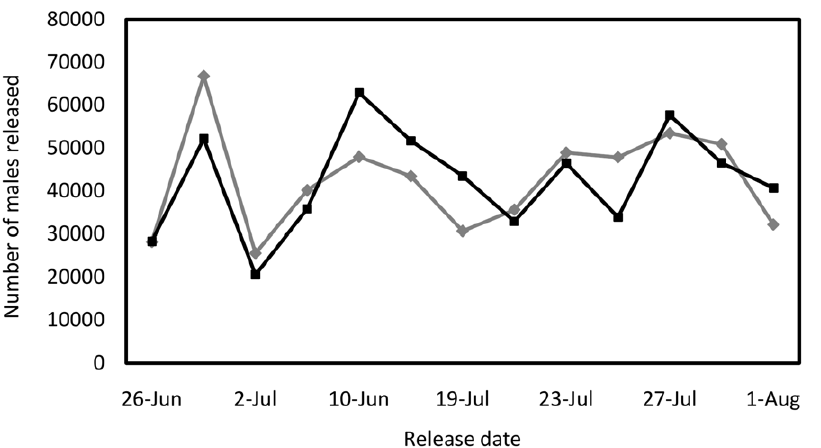
Figure 3. Number of OX1138B and APHIS male moths released over all fields during the trial period. Black line=OX1138B; grey line=APHIS.